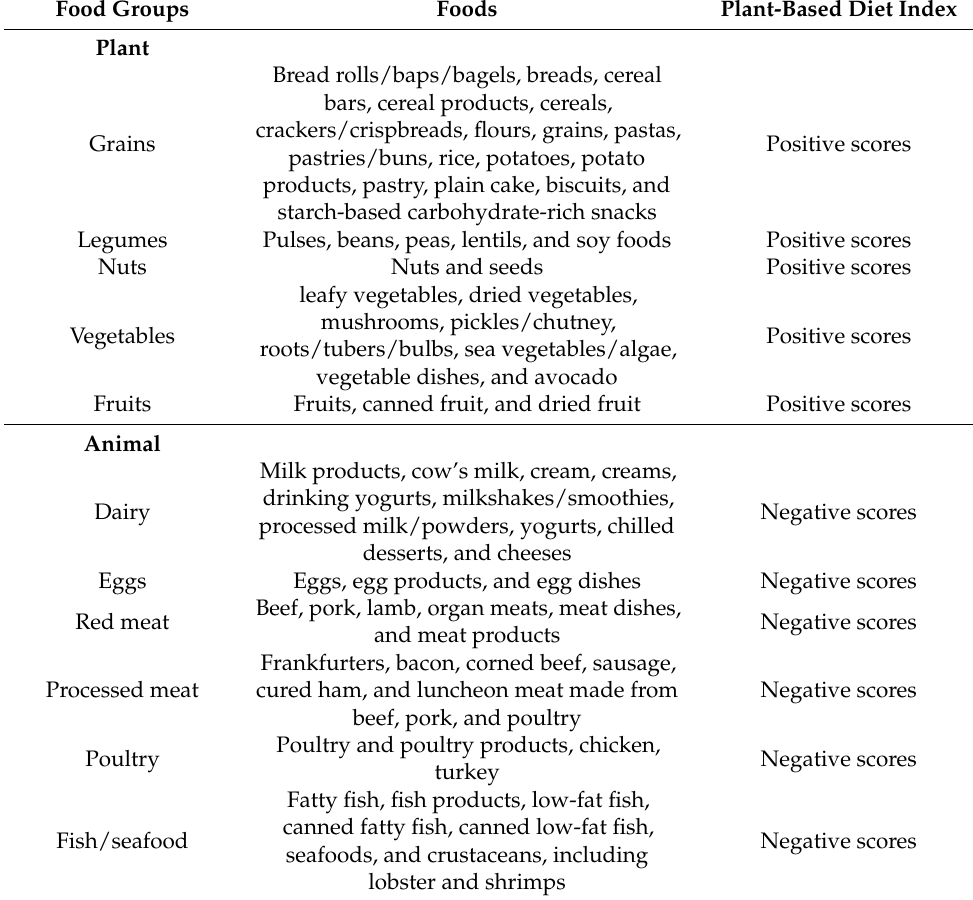
Table 1. Examples of food items in the 11 food groups. Food